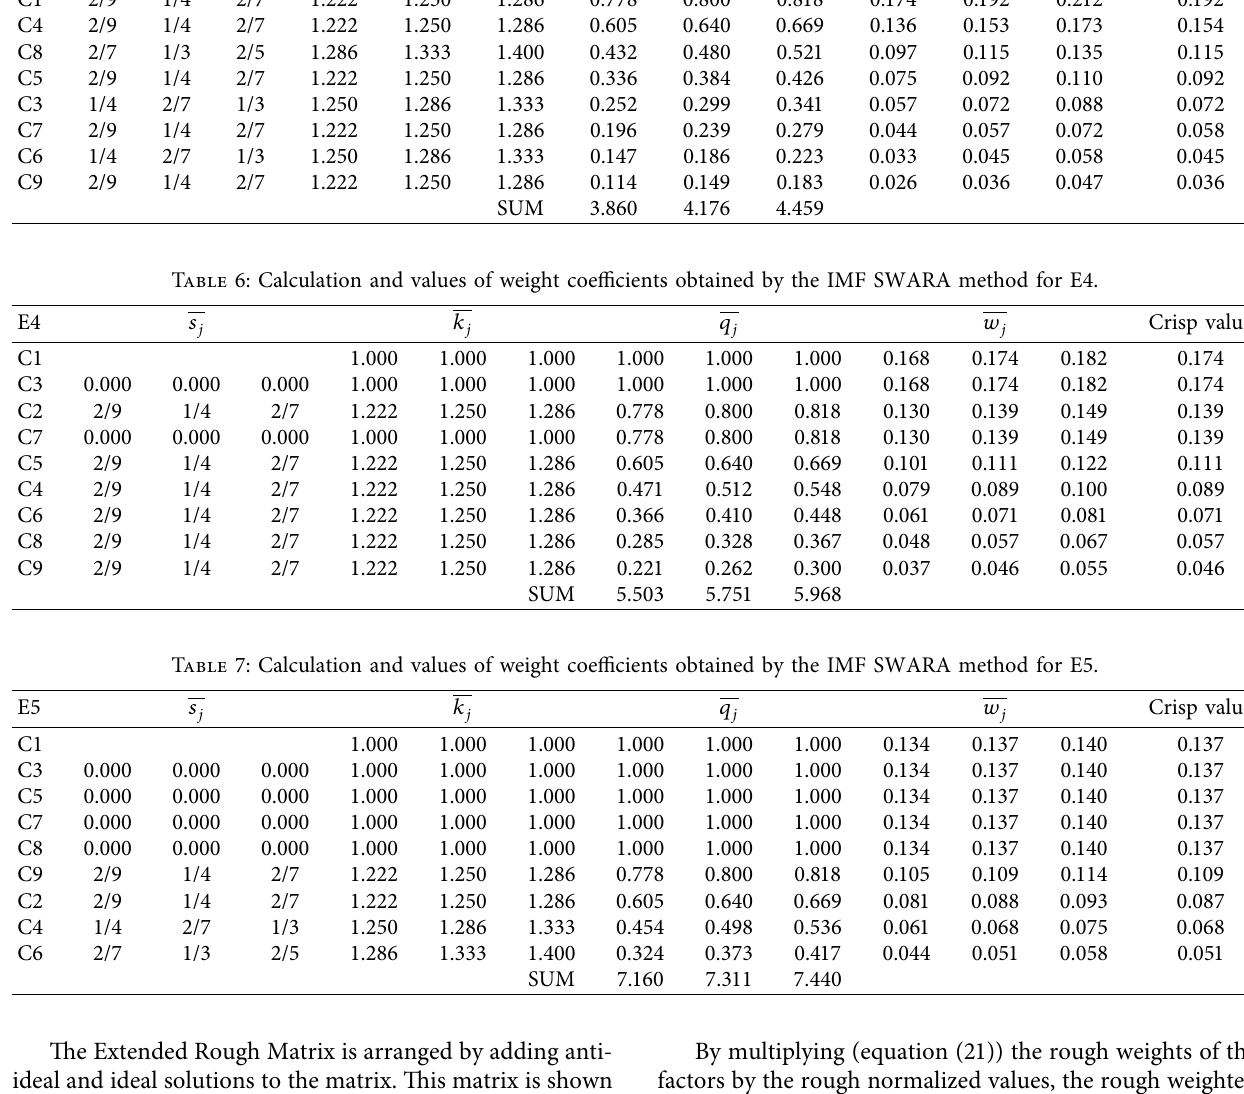
By multiplying (equation (21)) the rough weights of the factors by the rough normalized values, the rough weighted matrix is calculated and presented in Table 12.